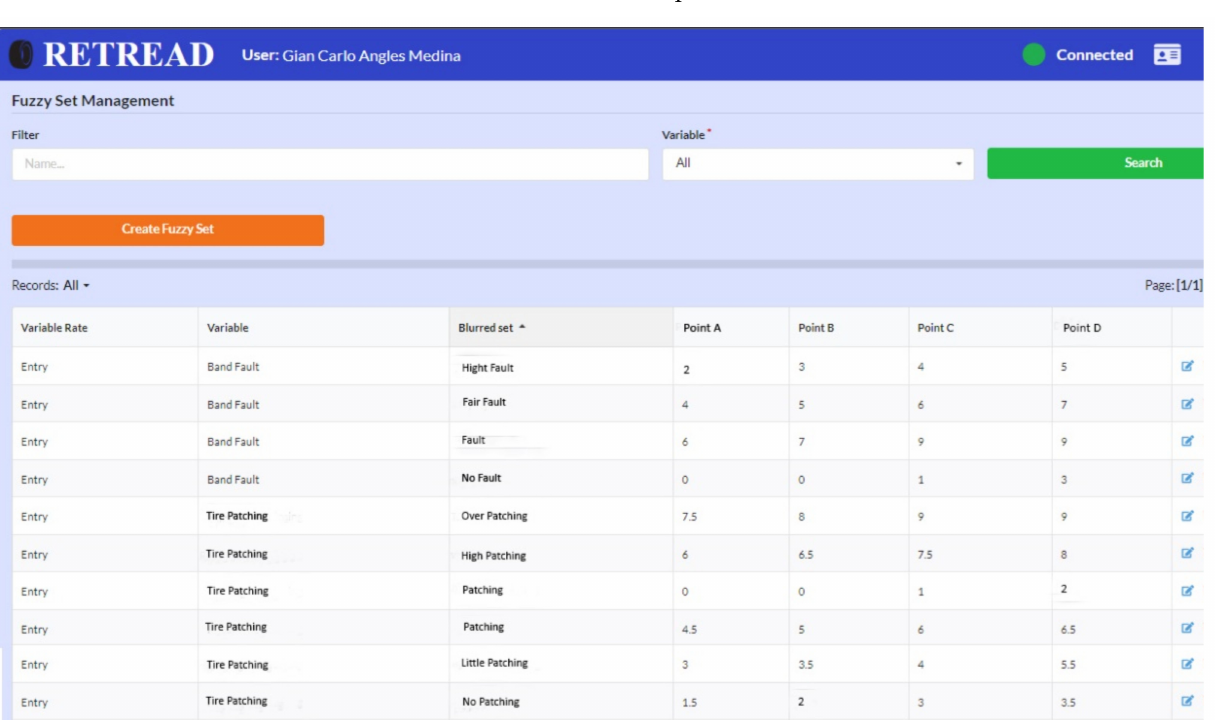
Figure 7. Fuzzy Set Management screen.